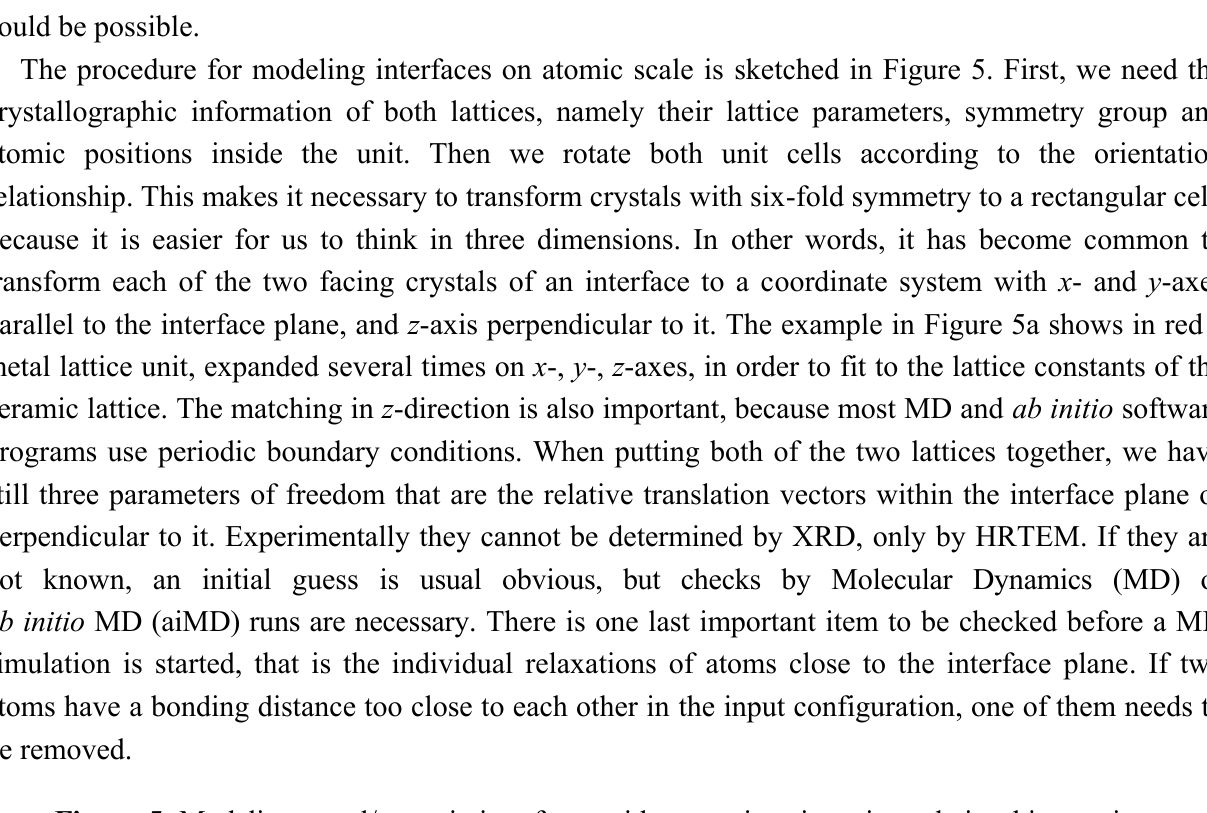
Figure 5. Modeling metal/ceramic interfaces with a certain orientation relationship requires inclusion of ( a ) misfit dislocations and/or; ( b ) difference in thermal